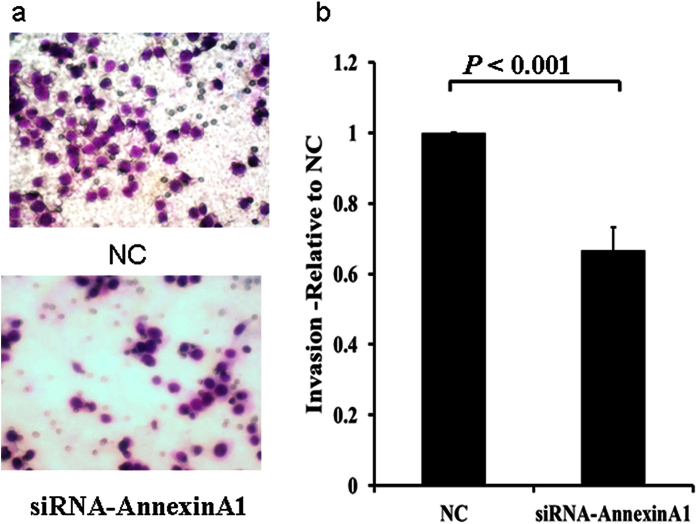
Knockdown of Annexin A1 by siRNA inhibits AGS cell invasion.Invasion assay was conducted with Annexin A1 siRNA or NC transfected AGS cells using 24-well Transwell chambers. (a) Representative images of invaded cells in NC and siRNA transfected cells. (b) Cell invasion was assessed by counting the number of AGS cells that invaded through the transwell insert by light microscopy on 3 independent membranes, then normalized against the NC treated cells to determine the relative ratio. The procedures for cell invasion are similar to that of migration except that matrigel was added to the upper chamber of the transwell.